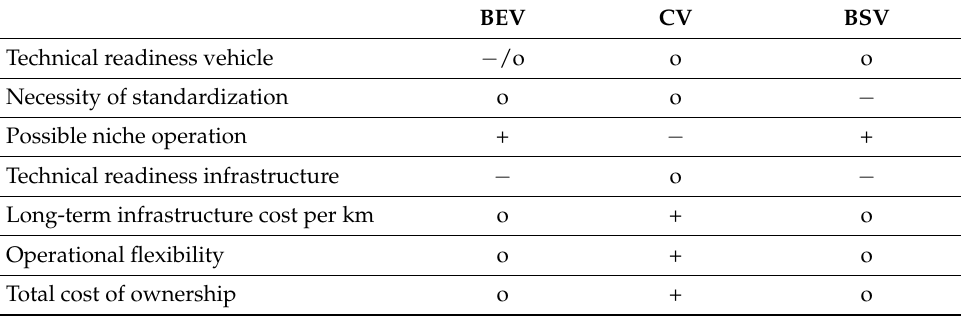
Table 8. Summary assessment in seven dimensions for long-haul